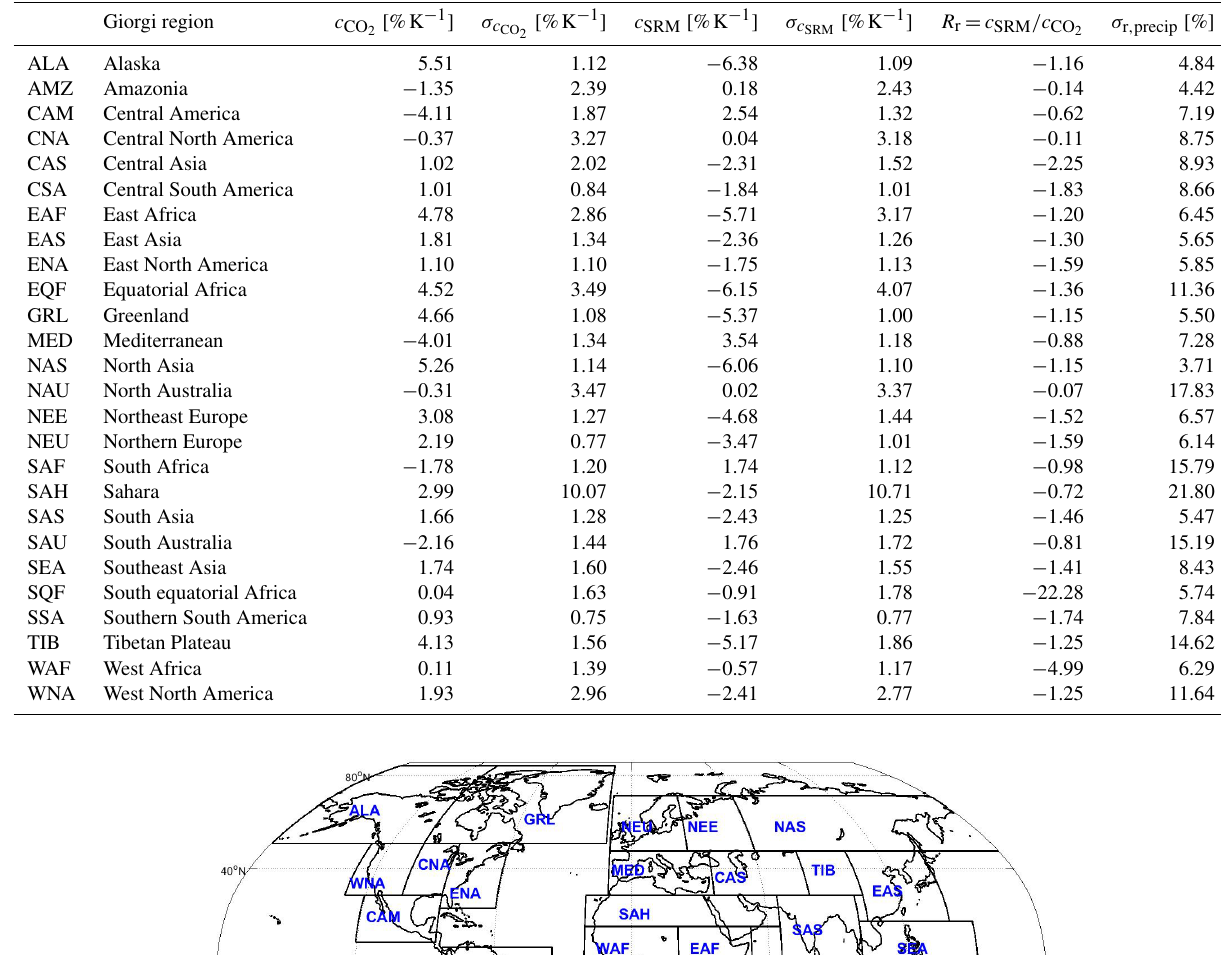
Table 1. Scaling characteristics of Giorgi regions. Giorgi region